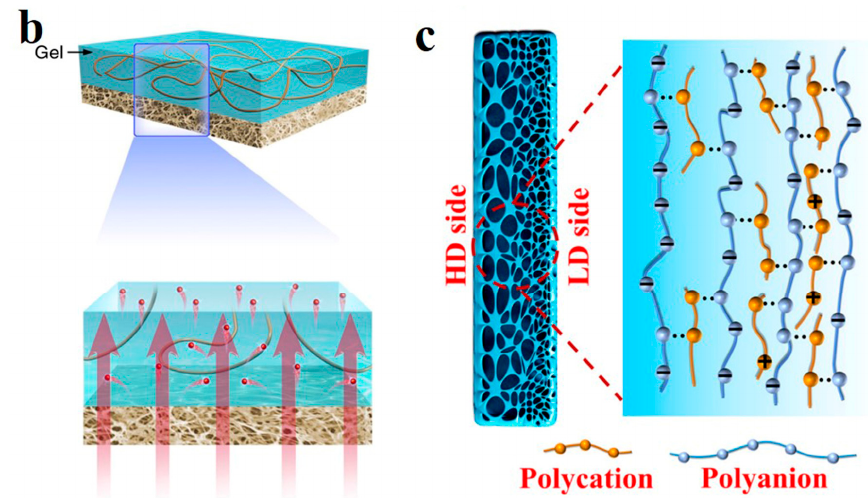
Figure 9. ( a ) Hydrogen bonding between CNF and PAM. Reprinted with permission from Ref. [114]. ( b ) Simulation of hydrogel/ANF heterogeneous membrane. Reprinted with permission from Ref. [119]. ( c ) Schematic diagram of gradient structure presented by hydrogel membrane. Reprinted with permission from Ref. [122].